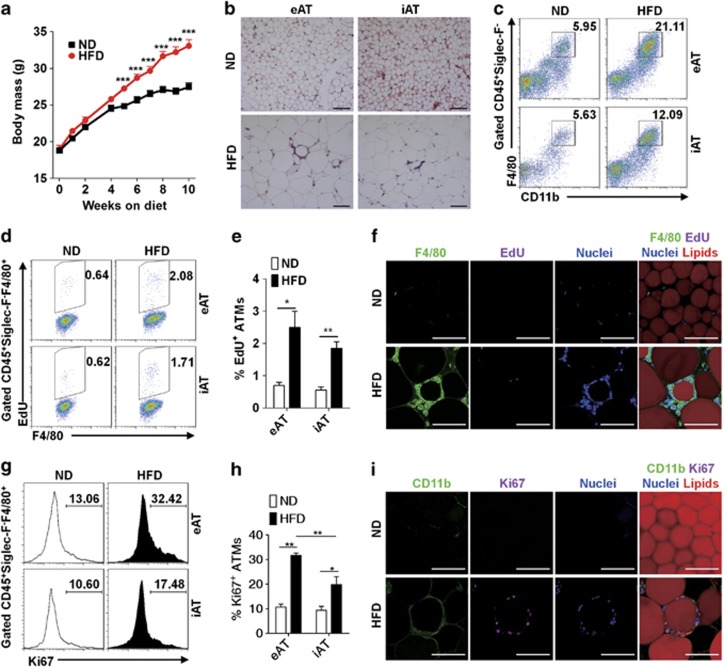
Macrophage accumulation in adipose tissue is associated with in situ proliferation at the early stage of obesity. (a) Body weight of mice fed with ND and HFD (n=10 mice in each group). Error bars represent means±S.E.M. ***P<0.001. (b) Hematoxylin and eosin staining showing leukocyte infiltration in eAT and iAT. Scale bars, 100 μM. (c) Flow cytometric analysis of ATM accumulation in eAT and iAT from ND- or HFD-treated mice. Representative dot plots are shown. Numbers on the graphs indicate the percentage of gated events in total events recorded. (d) Flow cytometric analysis of EdU incorporation in ATMs from eAT and iAT of mice on ND or HFD. Mice were pulsed with 10 μg EdU/g body weight for 3 h. (e) Summarizing of the data in panel (d) are shown as means±S.E.M. n=3–4 mice in each group, *P<0.05, **P<0.01. (f) Immunofluorescence staining for EdU-incorporated ATMs in eAT of mice on ND or HFD. Scale bars, 100 μm. (g) Flow cytometric analysis of Ki67 expression in ATMs from eAT and iAT of mice on ND or HFD. (h) Summarizing of the data in panel (g) are shown as means±S.E.M. n=3–4 mice in each group, *P<0.05, **P<0.01. (i) Immunofluorescence staining for Ki67+ ATMs in eAT of mice on ND or HFD. Scale bars, 100 μm